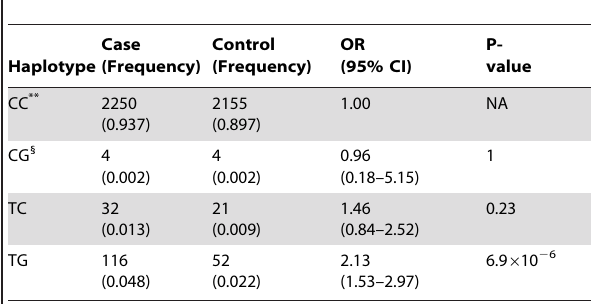
Table 5. Haplotype analysis of rs3809922 and rs3809923.